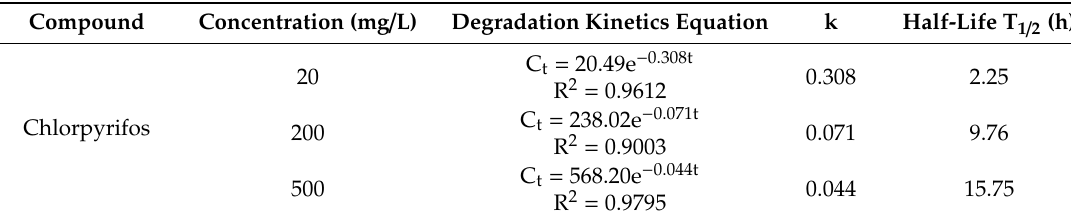
Table 1. Kinetic parameters for degradation of chlorpyrifos by C. nantongensis X1 T . Compound